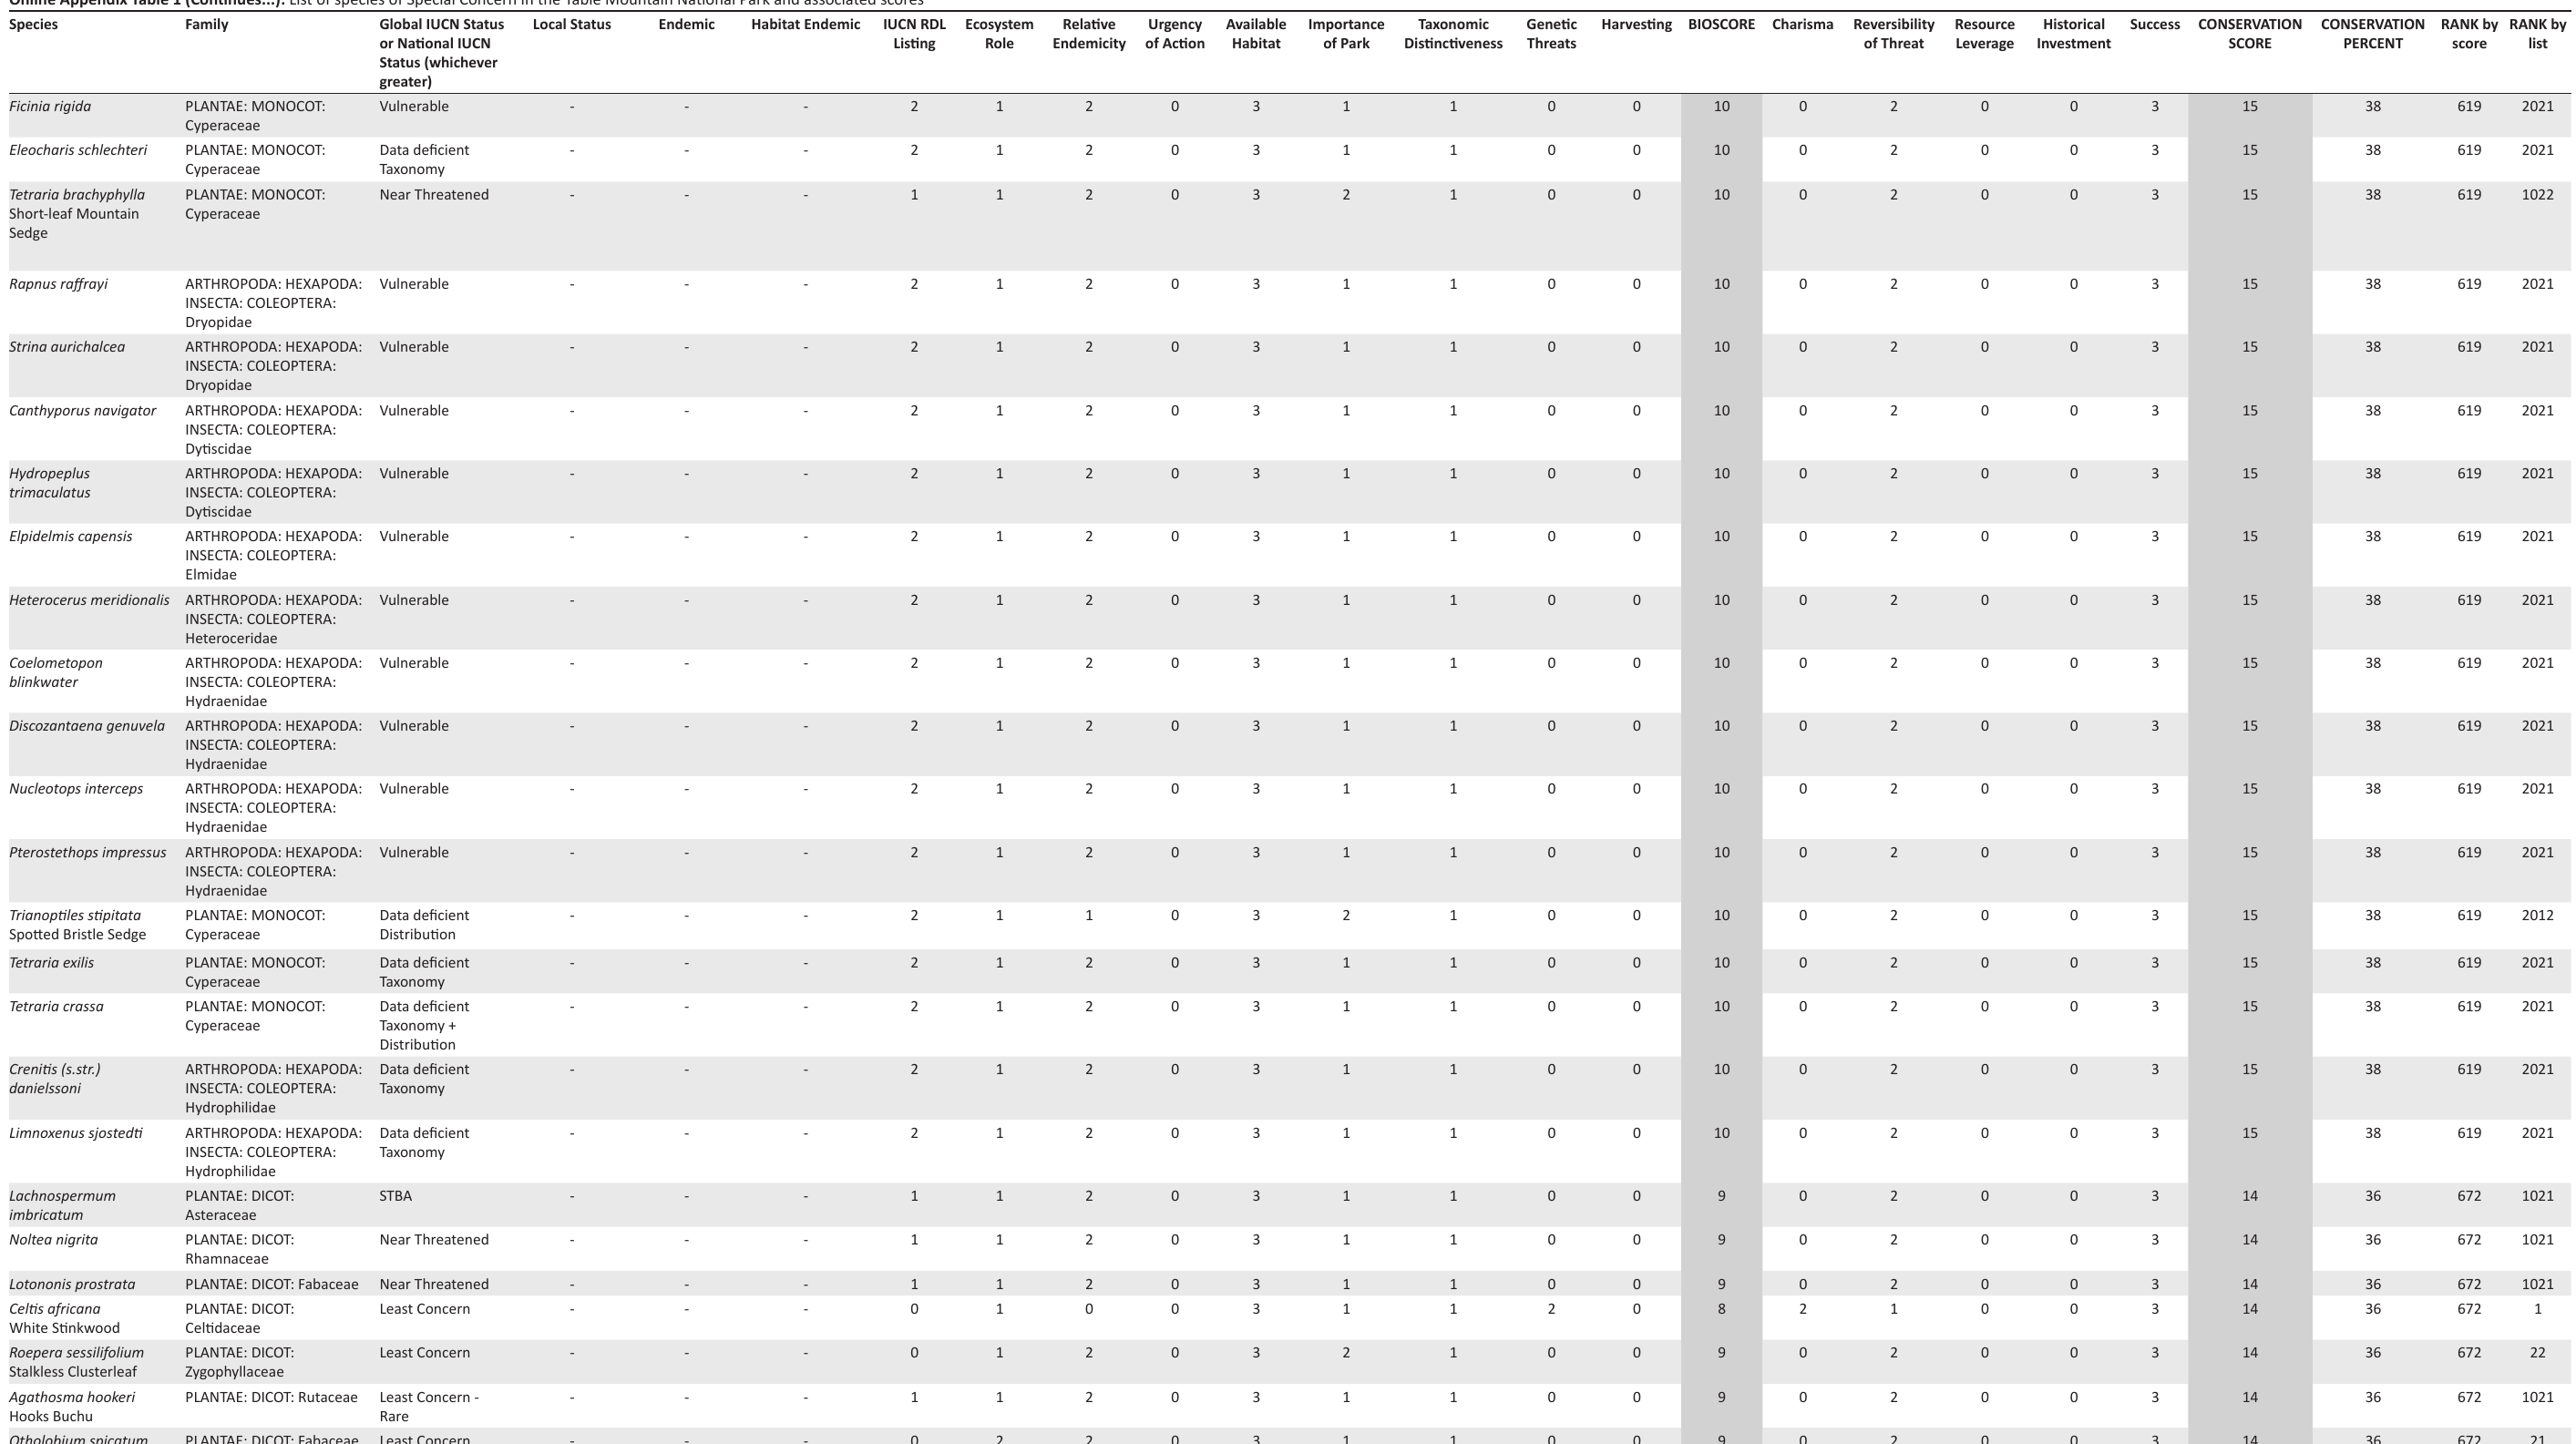
Online Appendix Table 1 (Continues...): List of species of Special Concern in the Table Mountain National Park and associated